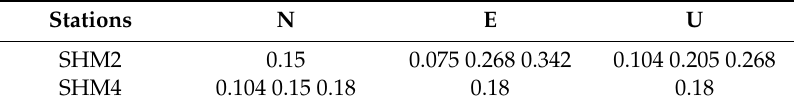
Table 6. Peak frequencies extracted from Figure 10 (Hz).